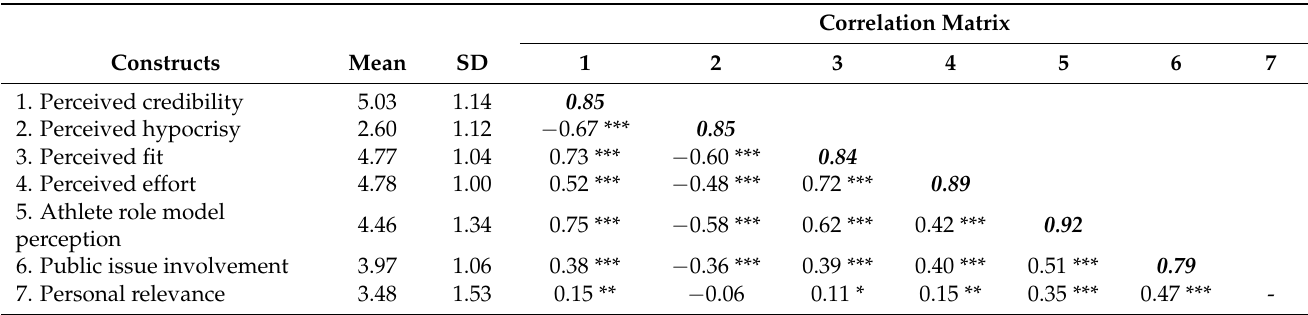
Table 3. Descriptive statistics and correlations of the constructs (Sample A: n =